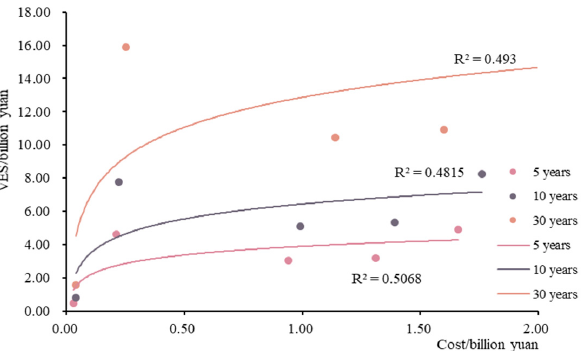
Figure 4. The initial costs including both direct and indirect cost invested in the project by the five coastal cities of Zhejiang (Wenzhou, Taizhou, Ningbo, Jiaxing and Zhoushan).